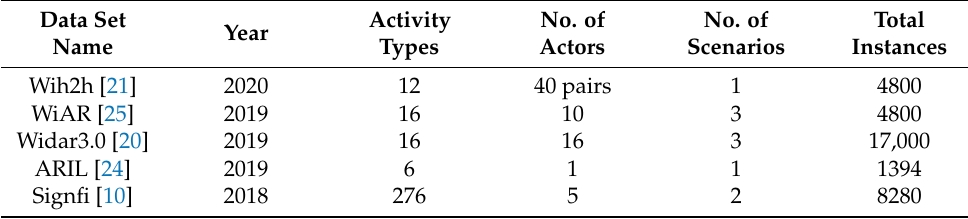
Table 1. The summary of the public data sets of WiFi-based human activity